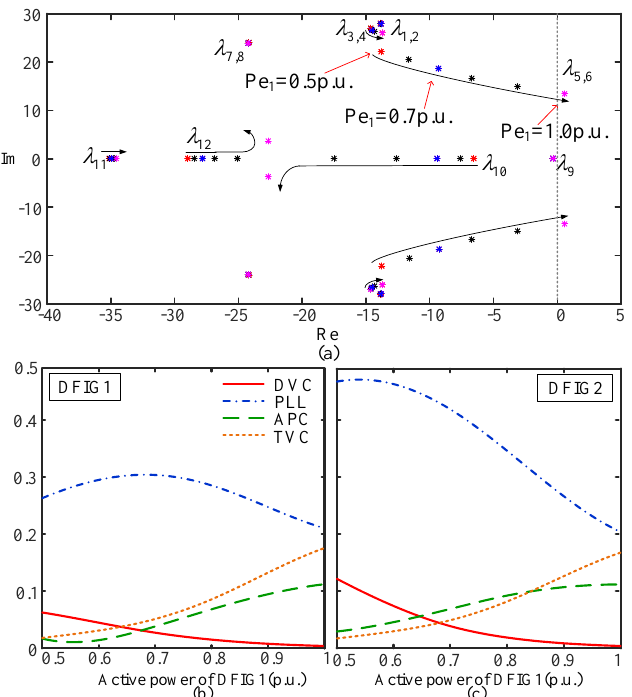
Figure 6. Stability analysis of a multi DFIGs system with different operating points. ( a ) Eigenvalue locus. ( b ) Participation factor curves for the dominant mode in DFIG1. ( c ) Participation factor curves for the dominant mode in DFIG2.